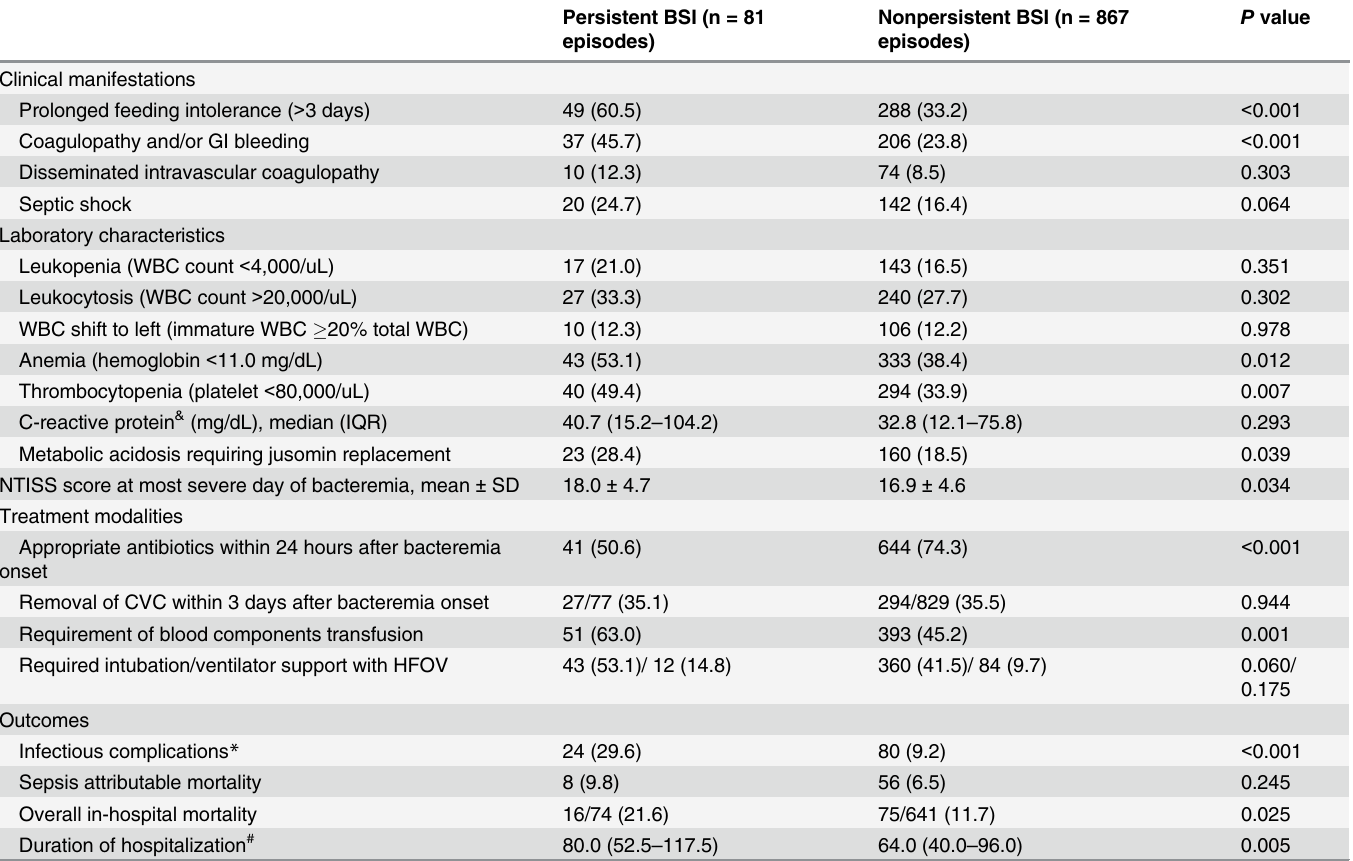
Table 3. Comparison of clinical manifestations, treatment and outcomes between persistent and nonpersistent bloodstream infection (BSI) in in- fants hospitalized in the neonatal intensive care